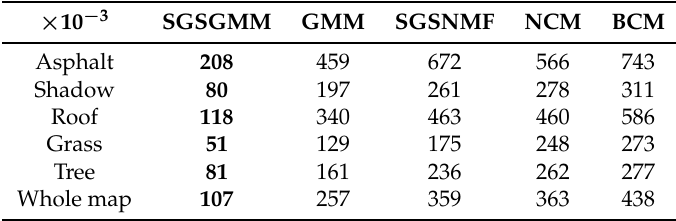
Figure 4. Abundance maps comparison for the ground truth, SGSGMM, Gaussian mixture model (GMM), spatial group sparsity regularized non-negative matrix factorization (SGSNMF), normal compositional model (NCM), and Beta compositional model (BCM). Table 1. Abundance errors for synthetic